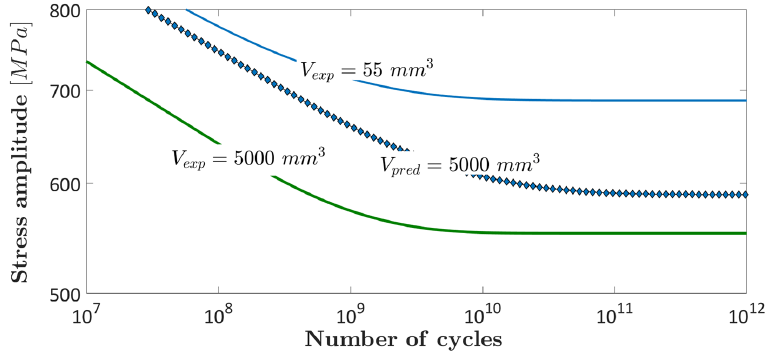
Figure 8. Median P–S–N curves estimated from the experimental data and predicted from test results on hourglass specimens.